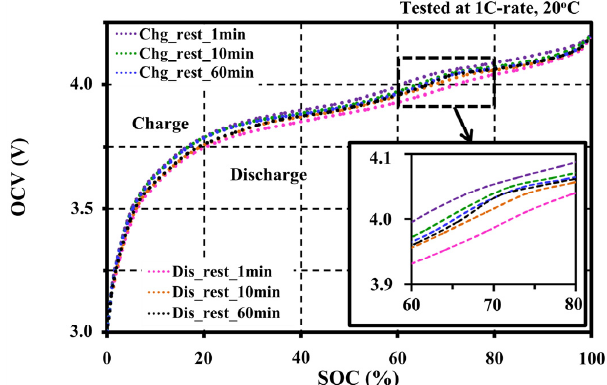
Figure 6. Effects of resting periods on the OCV characteristic.